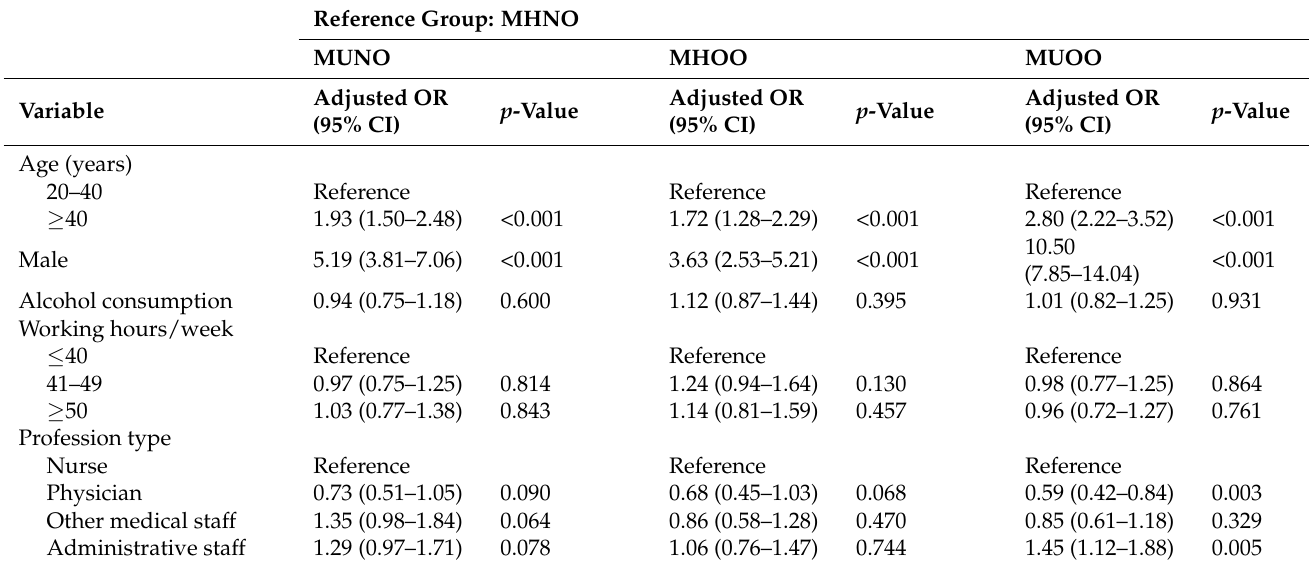
Table A2. Multivariable multinomial logistic regression for the association between basic demograph- ics and metabolic state in the cross-sectional